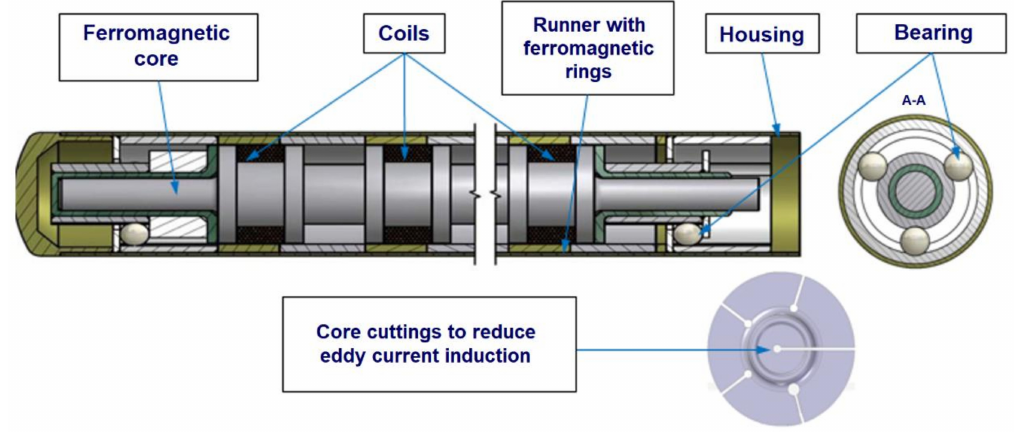
Figure 5. Construction of the penetrator drive system (tube reluctance actuator) used in the KRET